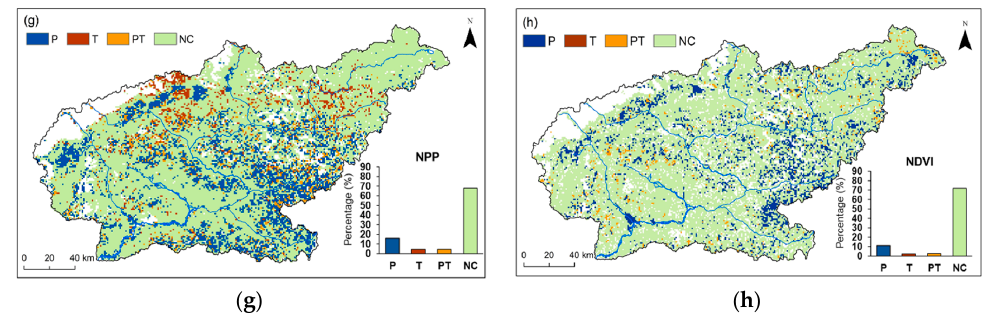
Figure 3. Driving factors of vegetation dynamics: ( a ) and ( b ) partial correlation coefficients between NPP and climatic variables; ( c ) and ( d ) partial correlation coefficients between NDVI and climatic variables; ( e ) and ( f ) multiple correlation coefficients between NPP (NDVI) and climatic variables; ( g ) and ( h ) the partitions for NPP and NDVI, the bar plots present the proportion of every driving factor.